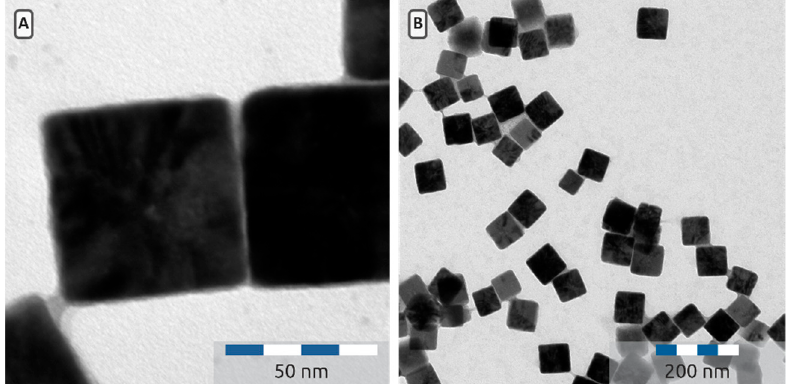
2.2 with 0.25 mL water and an edge length of 66 ± 8 nm. ( B ) Typical overview picture of the Cu 2 O particles (depicted at small length scales in ( A ). Clearly cubic particles with sharp edges are obtained.